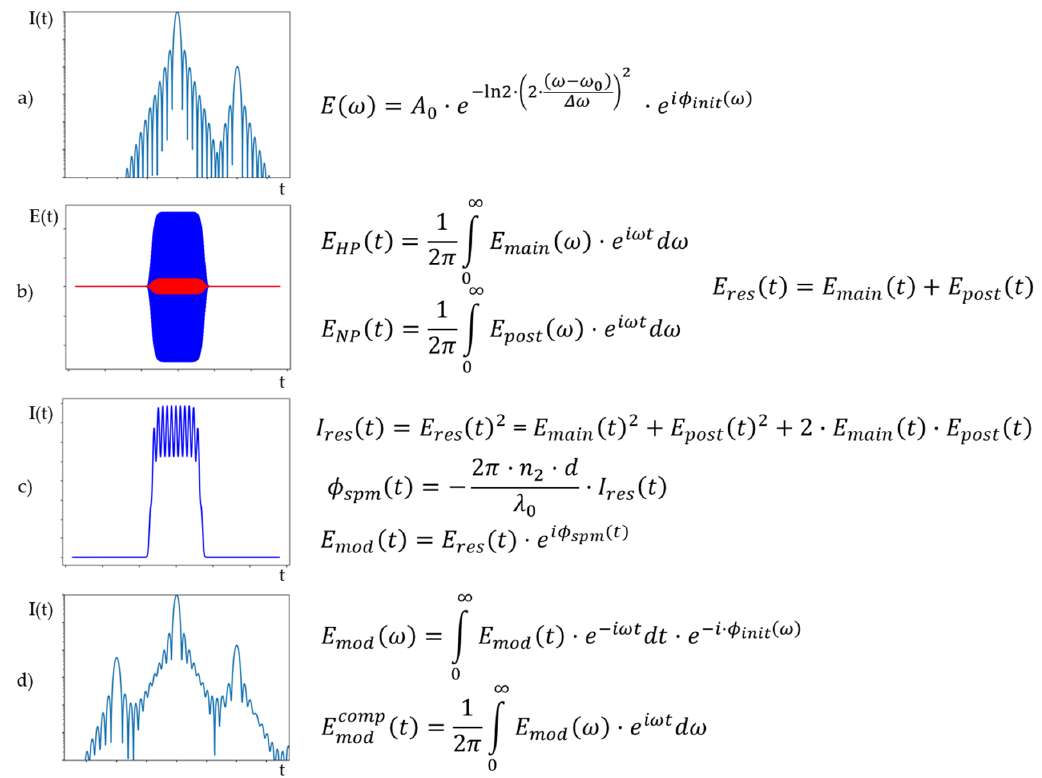
Figure 2. Description of the numerical simulation routine: ( a ) a main pulse and a post-pulse are generated in spectral domain together with their phase ( φ init spectral phase including delay, ω 0 central frequency, ∆ ω FWHM bandwidth, A 0 envelope). For checking of the initial intensity conditions both pulses are Fourier transformed with just the delay into time domain; ( b ) both pulses (blue: main pulse, red: post-pulse) are Fourier transformed to the temporal domain (stretched) and forming a joint electric field; ( c ) the joint electric field leads due to interference to a temporal intensity distribution with a modulated term. This term leads to a modulated nonlinear temporal phase retroacting back onto the joint field; ( d ) compression leads to a newly generated pre-pulse in the temporal domain.